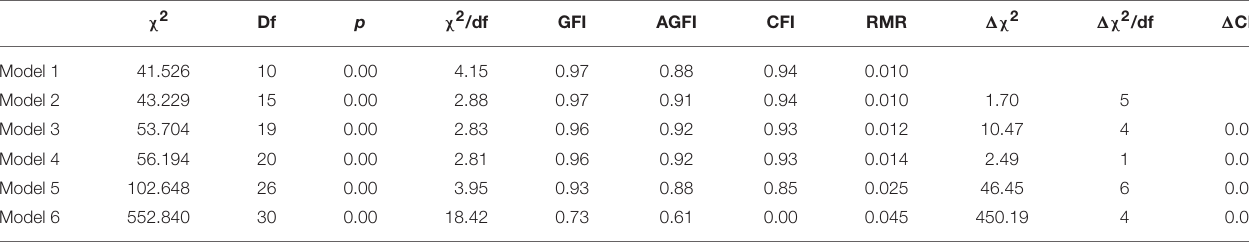
TABLE 5 | Comparative indexes for third model (dimension parental neglience). χ 2 Df p χ 2 /df GFI AGFI CFI 1 CFI